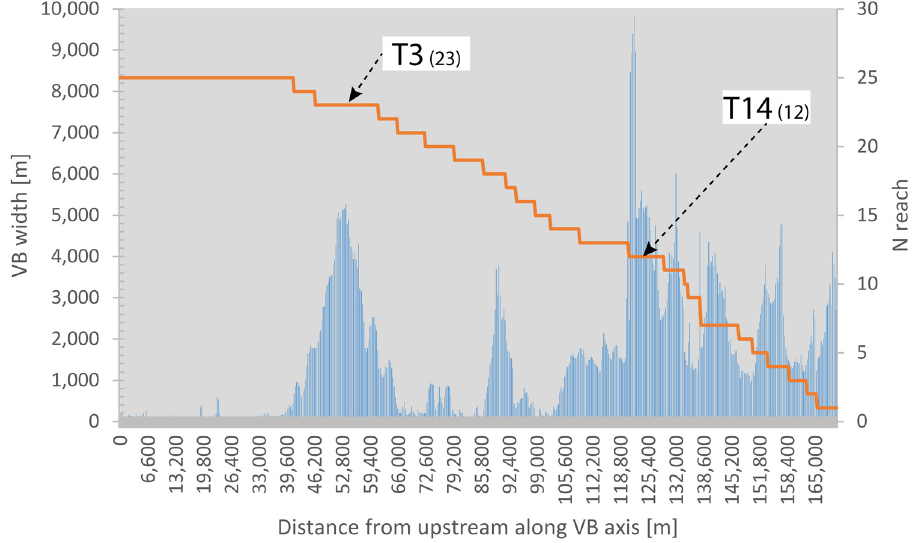
Figure 14. Baker case study: schematic representation of VB width (blue line) along the Baker River (upstream is on the left) and of the different reaches determined with the proposed procedure (orange line, with axis on the right); they range from the first on the left (T1, denoted as 25 on the right scale) to the last one on the right (T25). To improve visual perception, VB width values greater than 8 km have been cut (max is around 10 km) as they do not alter the general understanding, while hiding useful details (note: the numbering of reaches on the right axis does not relate to elevation; it is the complement of the one adopted in the following figures, for ease of representation here).